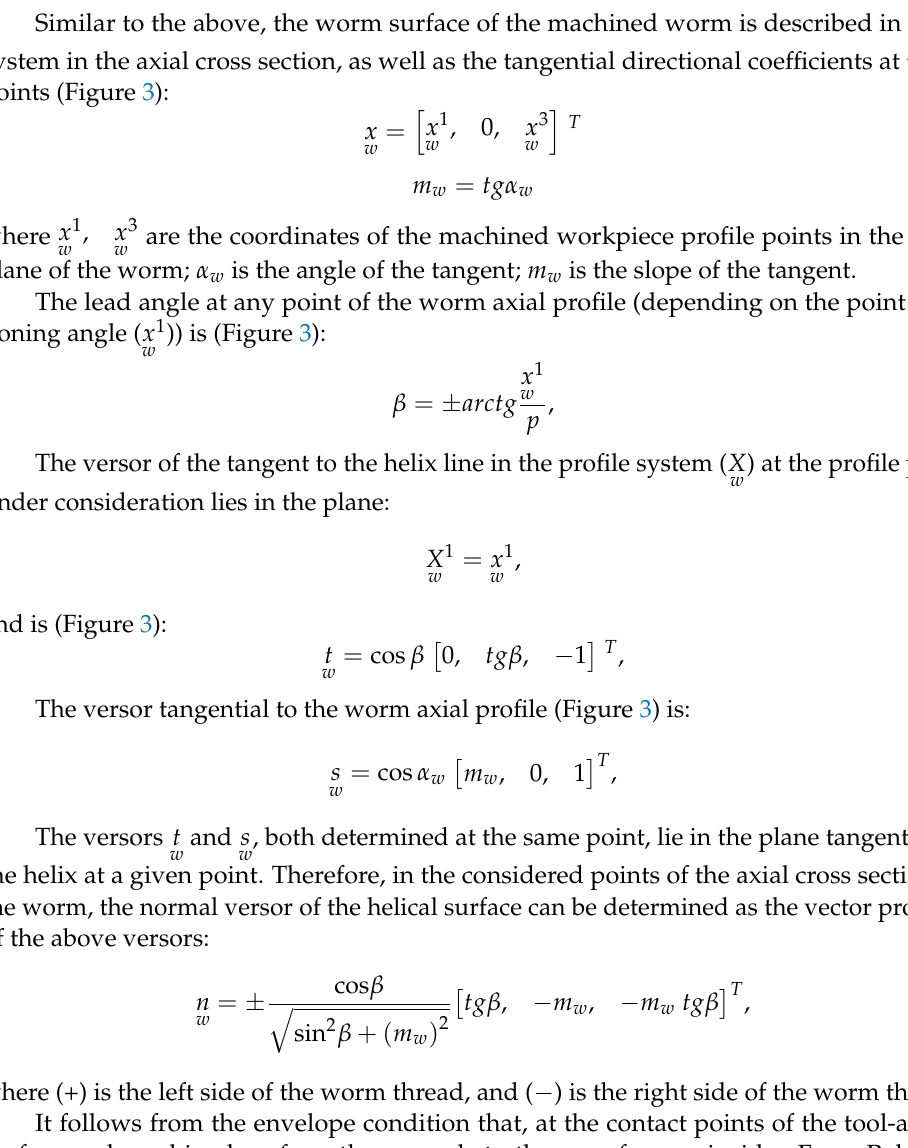
Figure 4. Authors’ program window: worm profile and profiles of partial helical surfaces in axial section: module: m = 5; outer diameter: d 1 = 48 (mm); k = 1 number of threads; number of passes = 50; worm axial profile radius: ρ = 15 (mm); milling cutter radius: ρ f = 2